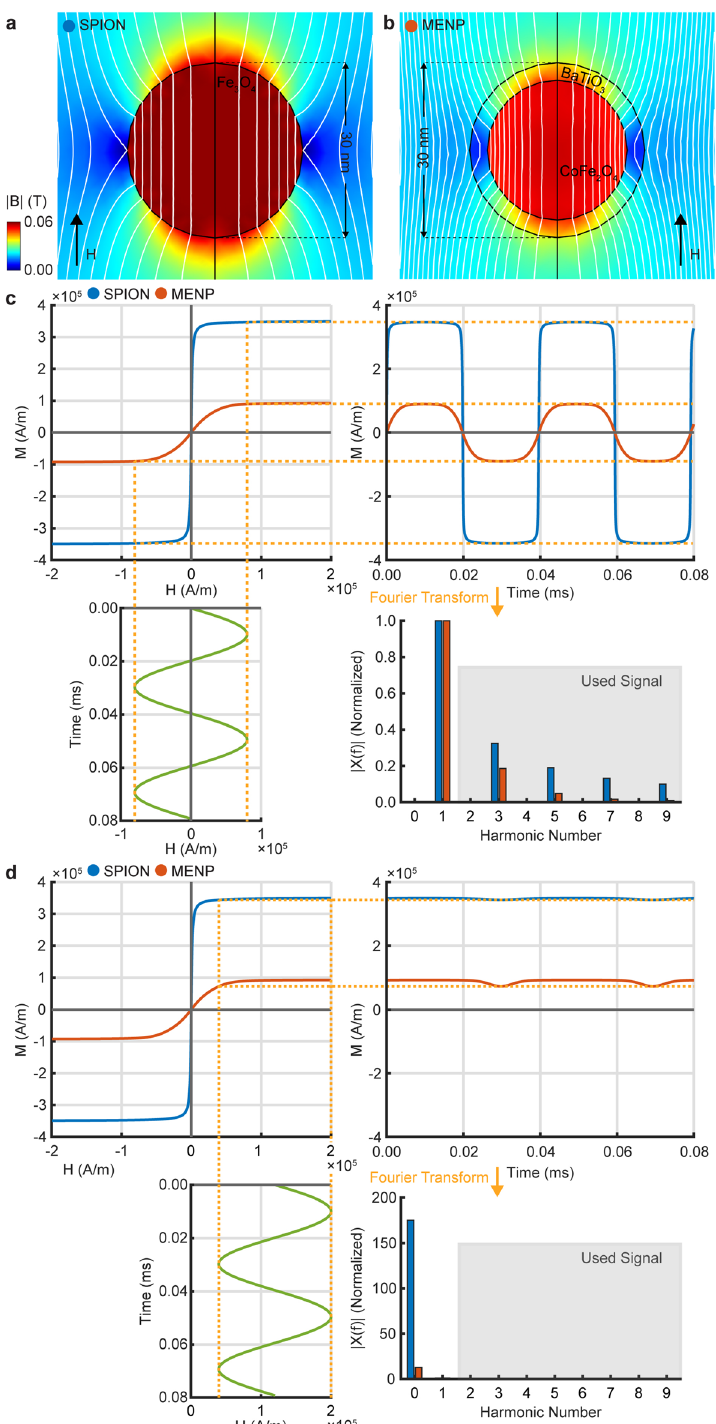
Figure 1. Magnetic flux density and magnetization harmonics for SPIONs and MENPs. ( a ) Magnetic flux density amplitude of a 30 nm SPION in response to 40 kA/m H- field (white contour lines—magnetic flux lines). ( b ) Response of a 30 nm CFO–BTO MENP to the same field. ( c ) Nonlinear magnetization and Fourier transform harmonics for SPIONs and MENPs in response to a 25.25 kHz, 80 kA/m oscillating H- field. ( d ) Magnetization saturation for SPIONs and MENPs with a 120 kA/m bias field to a 25.25 kHz, 80 kA/m oscillating H- field. For ( c ) and ( d ) values are normalized to the first harmonic of each particle